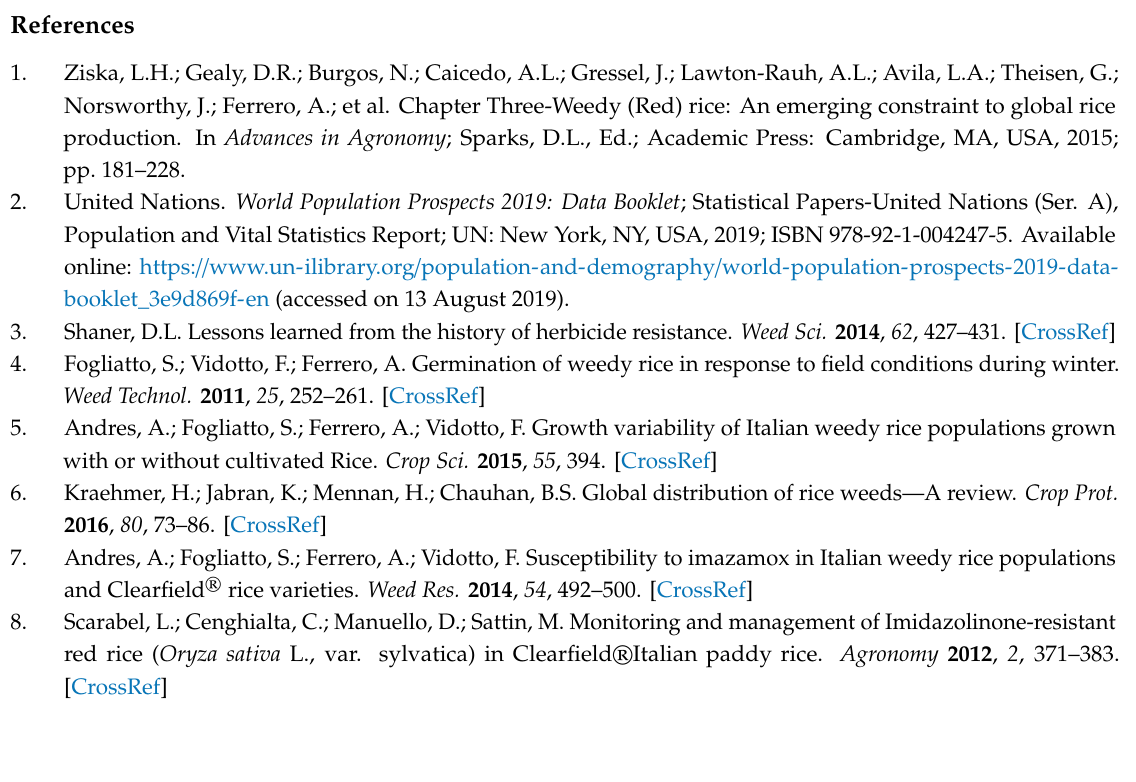
Figure S1: Germination percentage of the tested weedy rice populations and rice varieties as a function of NaCl concentration, as fitted by the following log-logistic model Y = d / {1 + exp[b(log(x) –